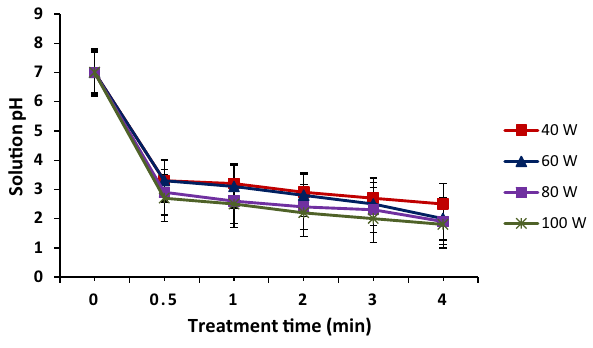
Fig. 10 Effect of input power in DBD plasma reactor on pH of the caffeine aqueous solution. Initial caffeine concentration: 100 µg/mL; volume of solution: 20 mL and initial pH: